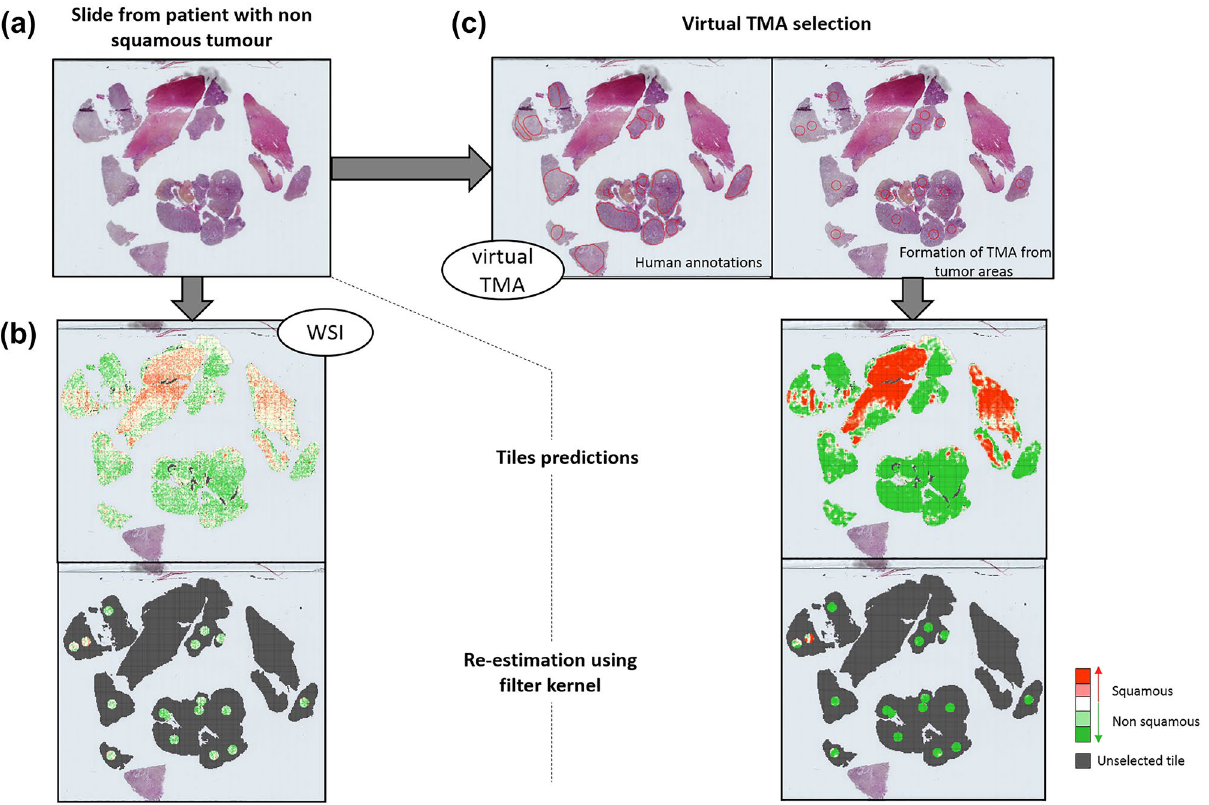
Figure 3. Predictions of tumour biopsy section containing non-squamous tumour. ( a ) Representation of original slide. ( b , c ) Steps for prediction analysis based on ( b ) whole Slide Image (WSI) or ( c ) virtual TMA strategy. Heatmaps show for each tile probability of being predicted as squamous tumour (red) or non- squamous tumour (green); the highest probability was kept for coloration; grey was used for tiles non selected by the pathologist or removed by denoising step (tile containing more than 2/3 of white